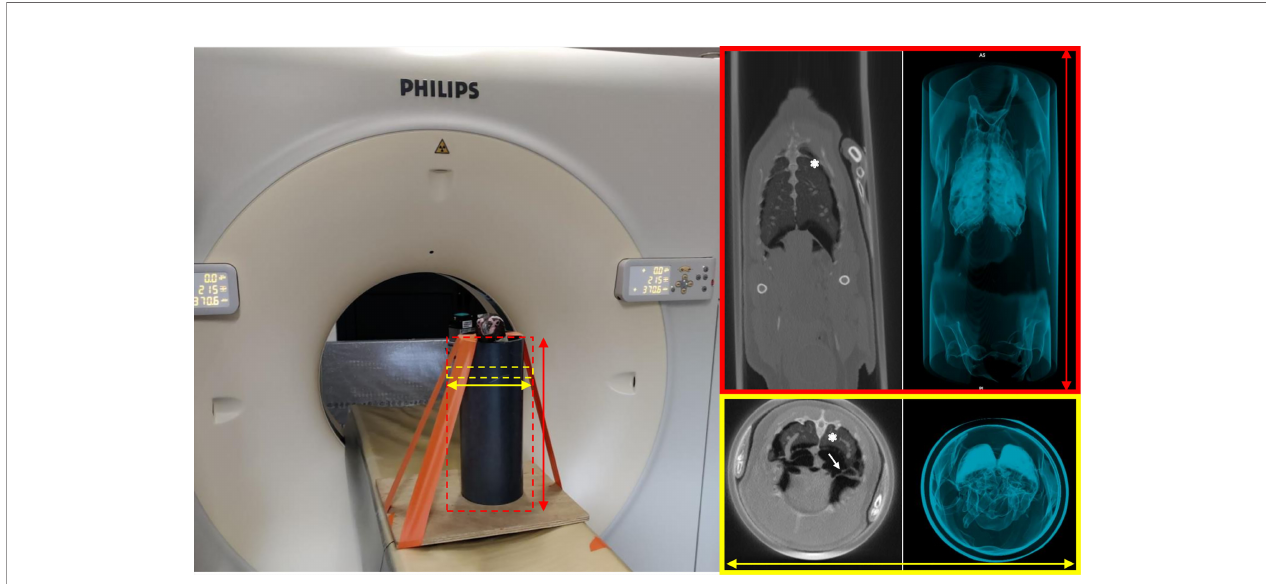
FIGURE 7 | Computed tomography in a non-anesthetized, standing Humboldt penguin. Dorsal (top right) and transverse (bottom right) sections of penguin n°13 are presented. The lung parenchyma (asterisks) and the thoracic air sacs walls (arrow) are well depicted. No lesions (nodules or plaques) are